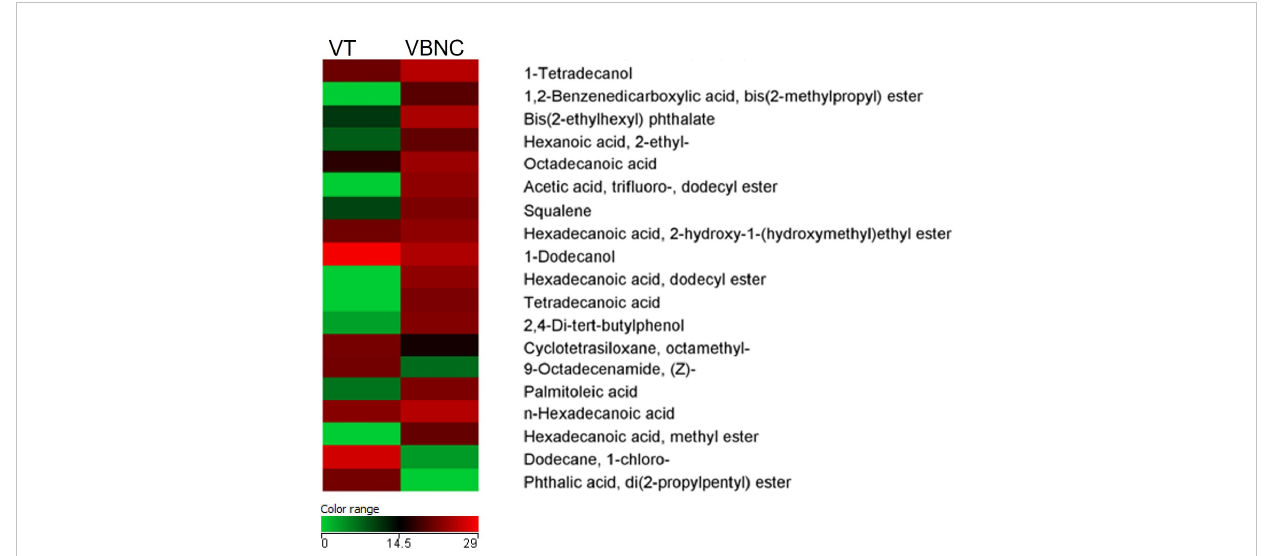
FIGURE 7 Heatmap of the quantitative variations of the selected metabolites based on the comparison between typical viable (VT) and viable non-culturable (VBNC) C. jejuni . Only compounds found in 100% of biological samples within at least one group were considered. Mann-Whitney, p < 0.05. Fold change > 2.00: 27 compounds, of which 19 have relevance to bacterial